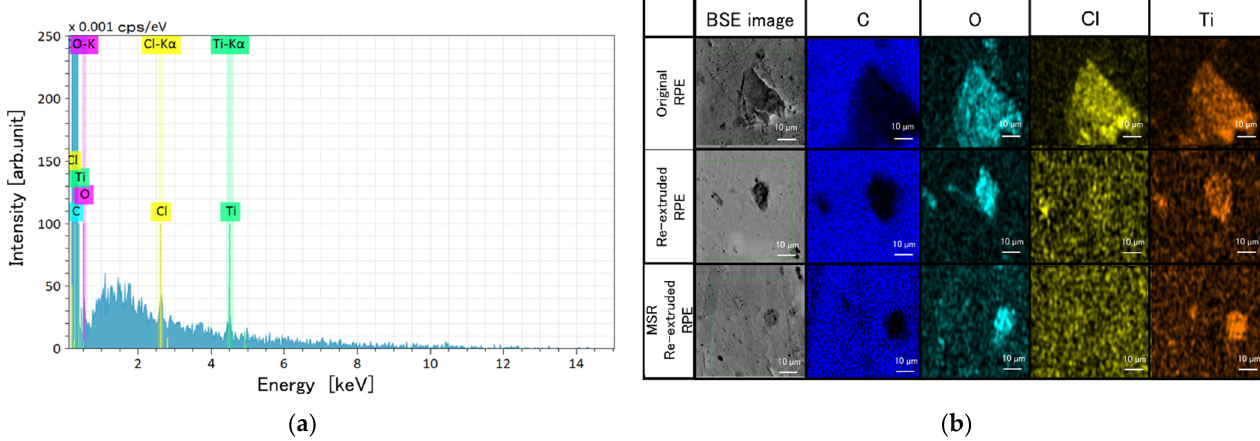
Figure 6. ( a ) Representative energy dispersive spectroscopy (EDS) data and ( b ) scanning electron microscopy-EDS mapping images of contaminant particles in the (from top to bottom) original sample and re-extruded samples prepared without and with a molten resin reservoir (BSE = backscattered electrons).